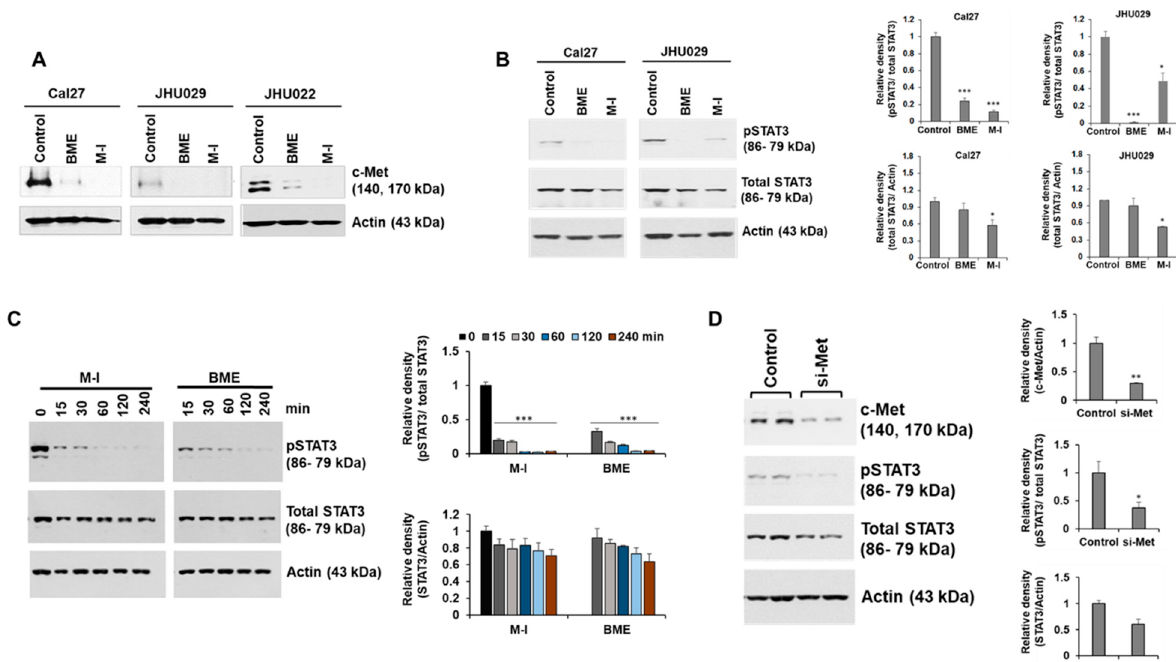
Figure 2. Momordicine-I inhibited c-Met signaling in HNC cells. ( A ) Cal27, JHU029 and JHU022 cells were treated with either 2% BME or 10 µ g/mL of M-I and JHU022 cells were treated with either 3% BME or 20 µ g/mL dose of M-I. Cell lysates were prepared after 48 hr of treatment and subjected to Western blot analysis using specific antibodies. Representative Western blot images for c-Met expression in Cal27, JHU029 and JHU022 cells are shown. Membrane was reprobed with the antibody for actin as an internal control. ( B ) Representative Western blot image for phospho-STAT3 (pSTAT3 Tyr-705) and total STAT3 expression in Cal27 and JHU029 cells with BME or M-I treatment. Membrane was reprobed by actin as an internal control. Quantitative representation of Western blot band intensities (right panel). Small bar indicates standard error (* p < 0.05; *** p < 0.001). ( C ) Cal27 cells were treated with 2% BME or M-I (10 µ g/mL) at indicated time points.